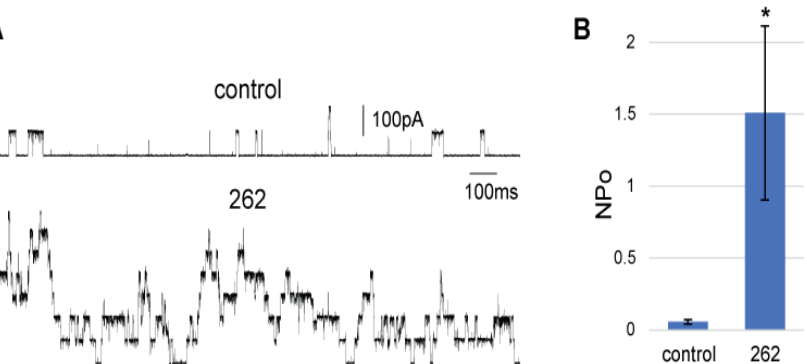
Figure 4. Compound 262 increases MscL activity in a patch clamp of native bacterial membranes. ( A ) Representative traces of MscL activity in an excised patch from bacterial giant cells, held at a pressure of − 110 mmHg, before (control) and after 10 min of the addition of 40 µM compound 262 to the bath. ( B ) Quantification of MscL channel activity measured as the open probability (NPo) of the channels in a patch held at the same pressure, before and after curcumin treatment. * p < 0.05 Student paired t -test (n = 5).